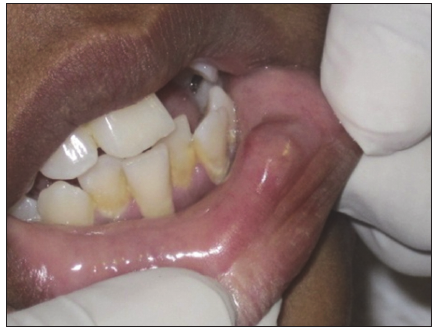
Figure 1: Swelling in the left labial mucosal region.